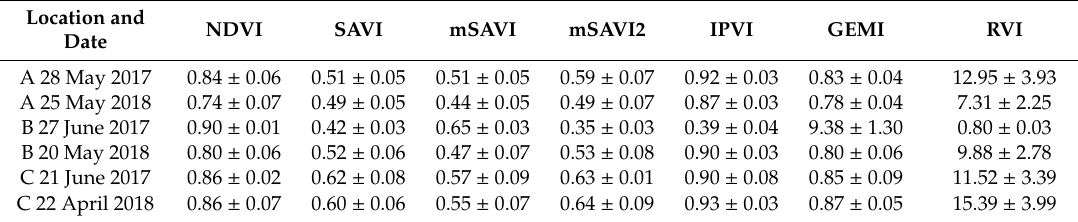
Table 4. Mean values and ± SD of vegetation indices for the dates when the highest NDVI values were observed.